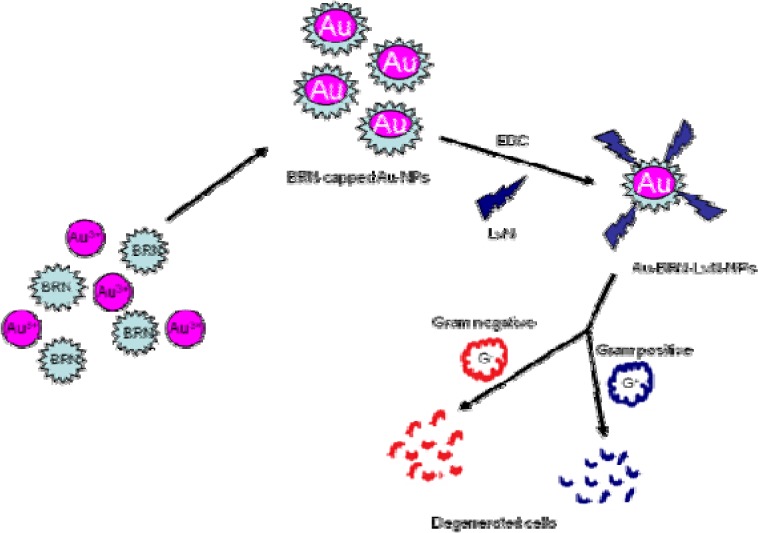
Graphical abstract